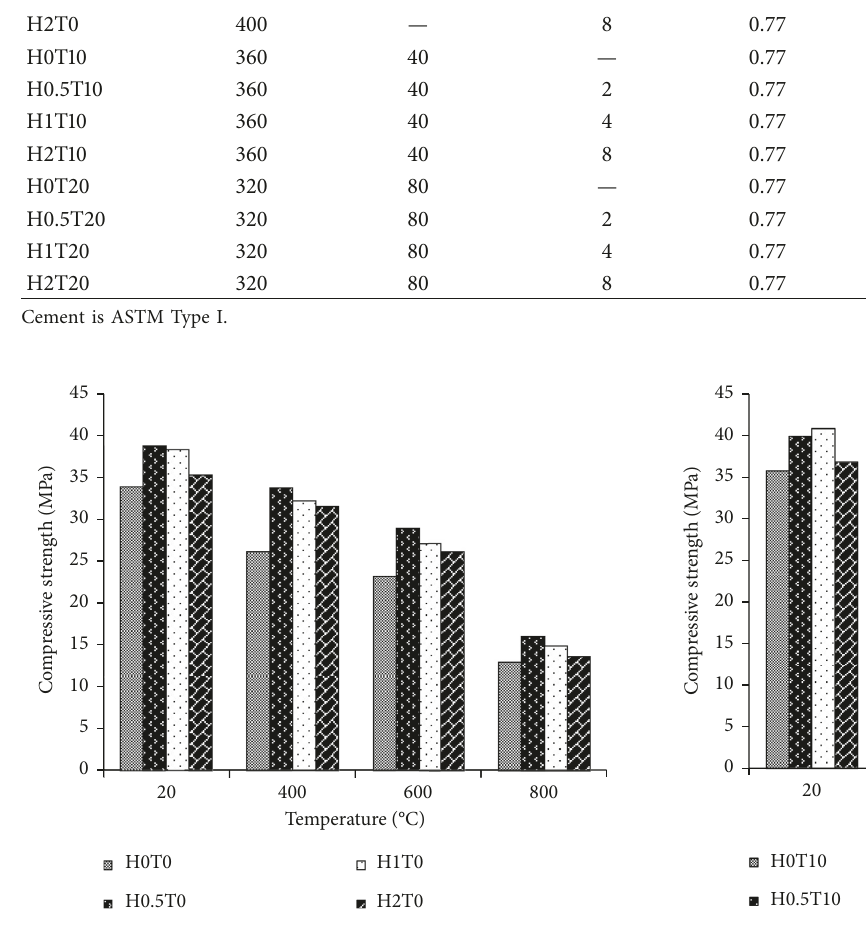
Figure 2: Compressive strength results for carbon fiber-reinforced lightweight concrete containing 10% silica fume.